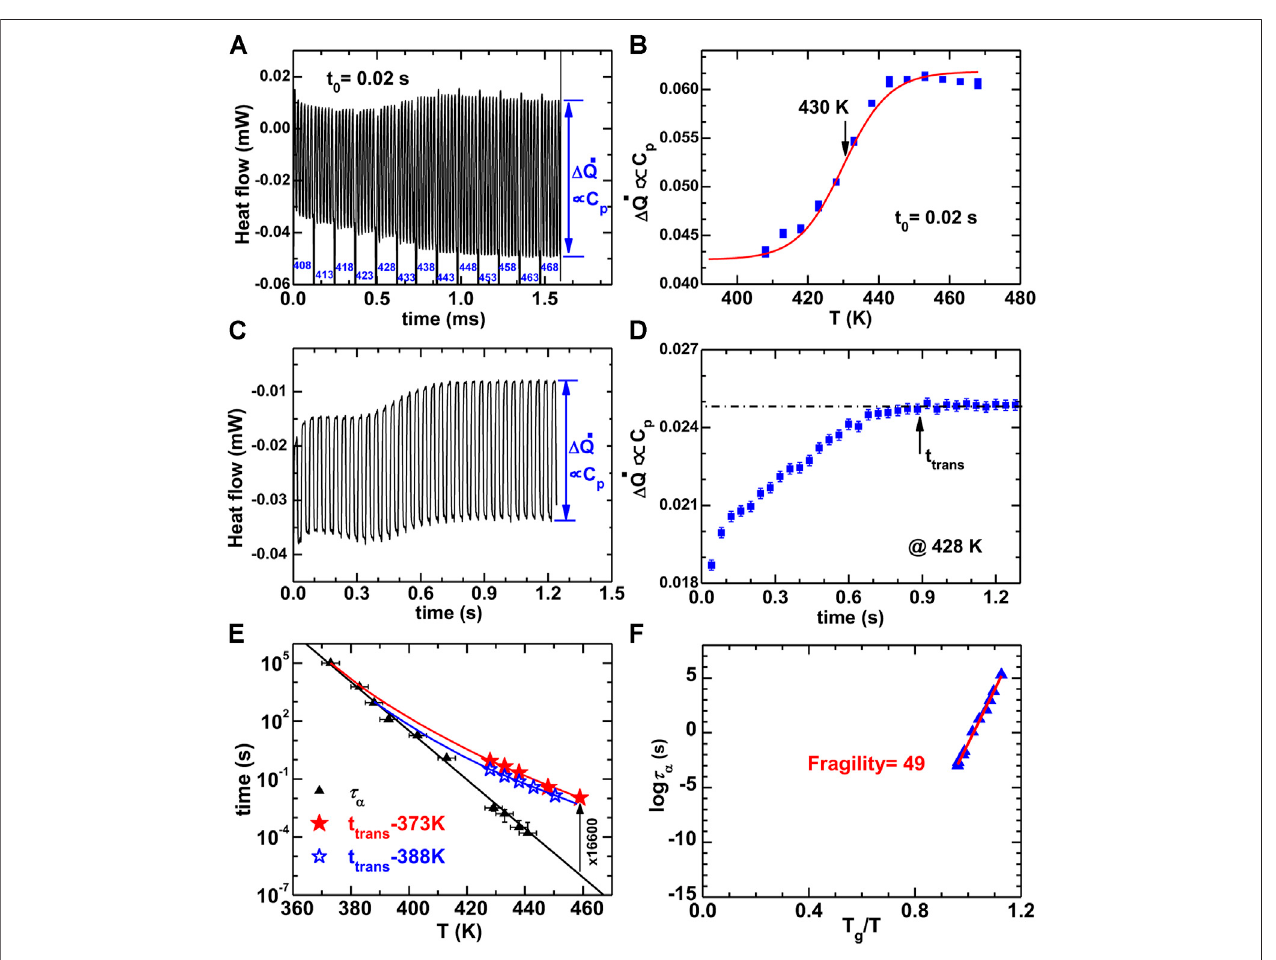
FIGURE13|(A) Theheat fl owcurveswithtimefor ac measurementofthe α -relaxationtime( τα (cid:2) t 0/2 π (cid:2) 0.0032 s). (B) The Δ Qevolutionwiththetemperature. (C) The heat fl ow with time for the measurements of glass-to-liquid de-aging transition time at 428 K based on the above ac method. (D) According to the evolution of Δ Q , the t transcanbeabout0.88 s. (E) Theevolutionof τα and t transwithtemperatureforthehighlystableglassesequilibratedat373and388 K,respectively. (F) TheAngell plot of τα ad T g/ T. The fragility of the Au 49 Cu 26.9 Ag 5.5 Pd 2.3 Si16.3 can be calculated as about 49. (from (Wang et al., 2016)).